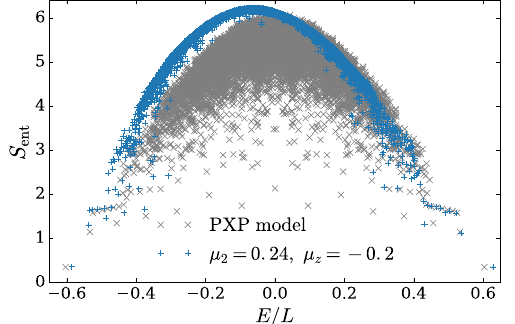
0 . 4 effectively z ¼